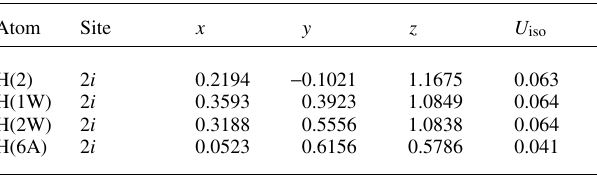
Table 2. Atomic coordinates and displacement parameters (in Å 2 )